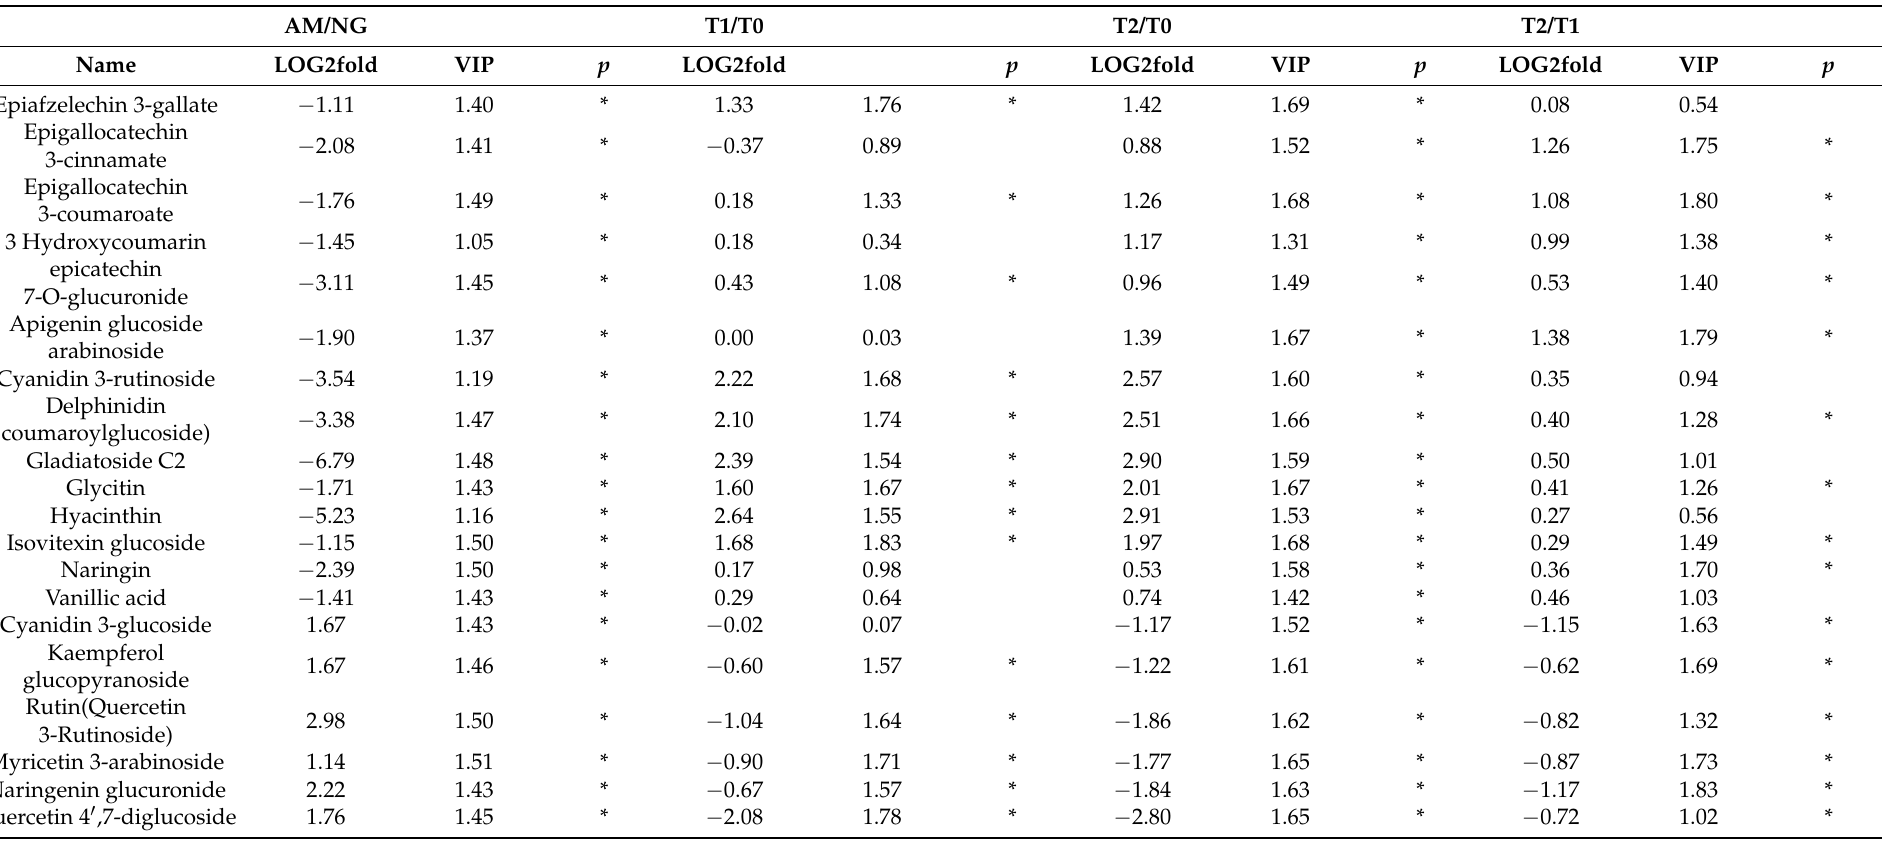
Table 2. Putatively identified secondary metabolites, analyzed by LC-MS, showing significant changes in their relative abundance in young shoots of tea plants at the indicated time points under greening